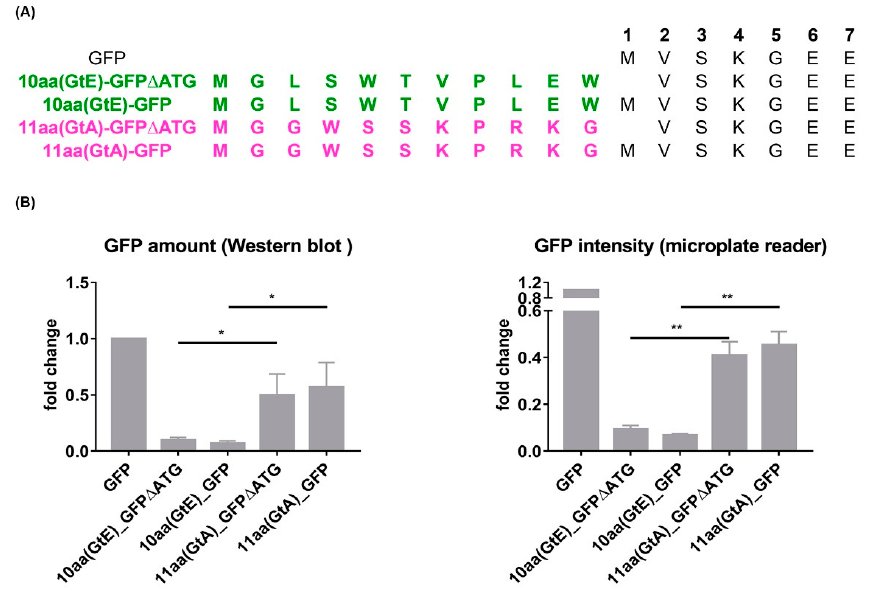
Figure 8. N-terminal 10-aa-deletion in GtE PreS1 domain increases dramatically the production and release of LHBs. ( A ) Supernatants and lysates from Huh7.5 cells transfected with genomes GtE and the derivatives were analyzed by Western blot using the PreS1-specific serum (MA18 / 7) and the core-specific serum (K46). β -actin was used as loading control. ( B – D ) The signals of LHBs and core in the Western blot were quantified by Image studio lite from LI-COR Biosciences. ( E , F ) Supernatants from Huh7.5 cells transfected with genomes GtE and the derivatives were analyzed by core ELISA and HBsAg ELISA. pUC18-transfected cells were used as negative control. The signal from GtE was standardized as 1. *, p < 0.05; **, p < 0.01; ***, p < 0.001.